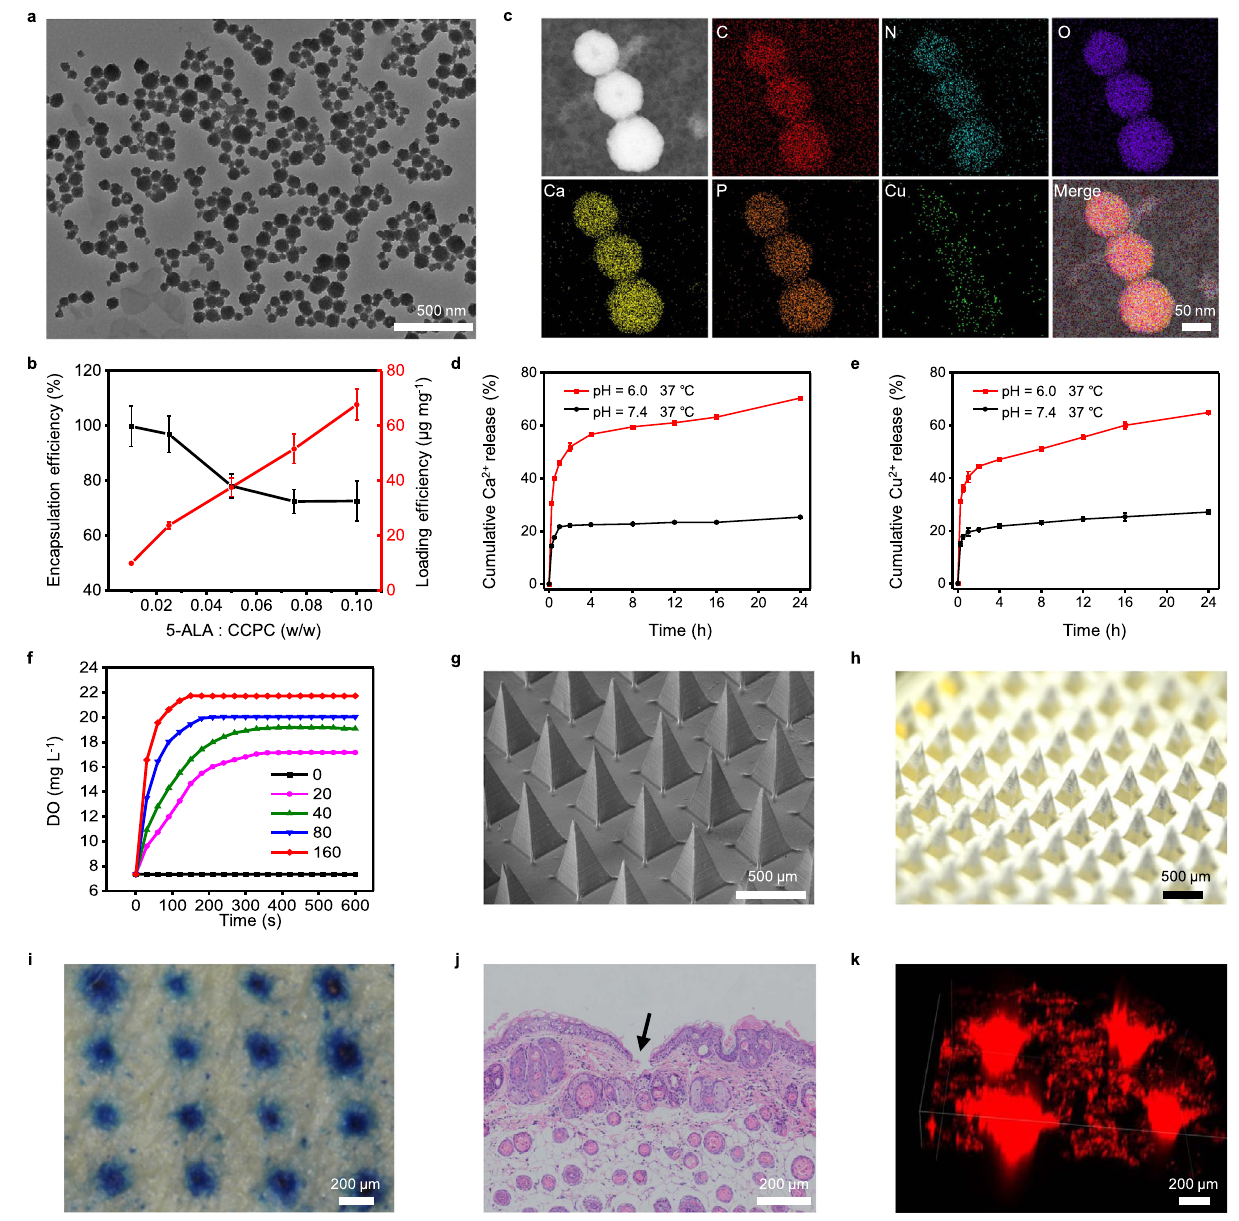
Fig. 2 | Characterization of CCPCA NPs and MN-CCPCA patches. a Representative TEM imageof CCPCA NPs, scalebar=500nm, n =3 independent experiments. b Loadingef fi ciencyandencapsulationef fi ciencyof5-ALAatdifferent 5-ALA: CCPC NPsfeeding ratios. Datarepresent the means±SD ( n =3). c Elemental mapping analysis of CCPCA NPs, scale bar=50nm. Images are from three inde- pendentsamplesofCCPCANPs. d TheCa 2+ and e Cu 2+ releasepropertiesofCCPCA NPs inphosphate buffer solution atpH 6.0 and 7.4.Data represent the means±SD ( n =3). f Time-dependent changes in dissolved oxygen (DO) in H 2 O 2 (1mM) after adding CCPCA NPs at various concentrations (0 – 160 μ gmL − 1 ), n =3